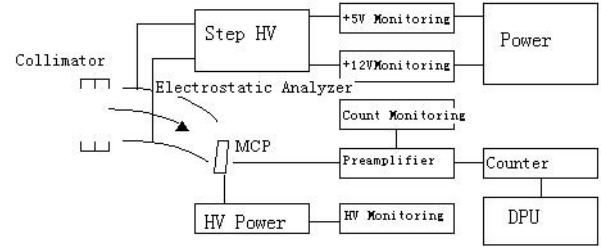
Fig. 5. Block diagram of